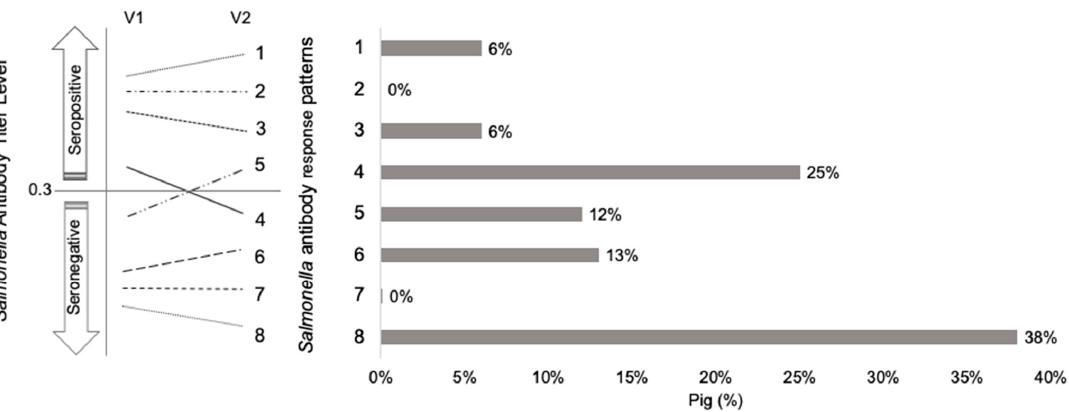
Figure 1. The change in Salmonella antibody titres in nursery pigs ( n = 930, from 50 swine cohorts) from weaning, at visit 1 (V1), to the end of the nursery, at visit 2 (V2), is characterized into eight possible Salmonella antibody response patterns (1–8) a . Salmonella seropositivity status (seropositive (Sp) if antibody titre level (based on S / P ratio) ≥ 0.3, seronegative (Sn) if antibody titre level < 0.3). a Salmonella